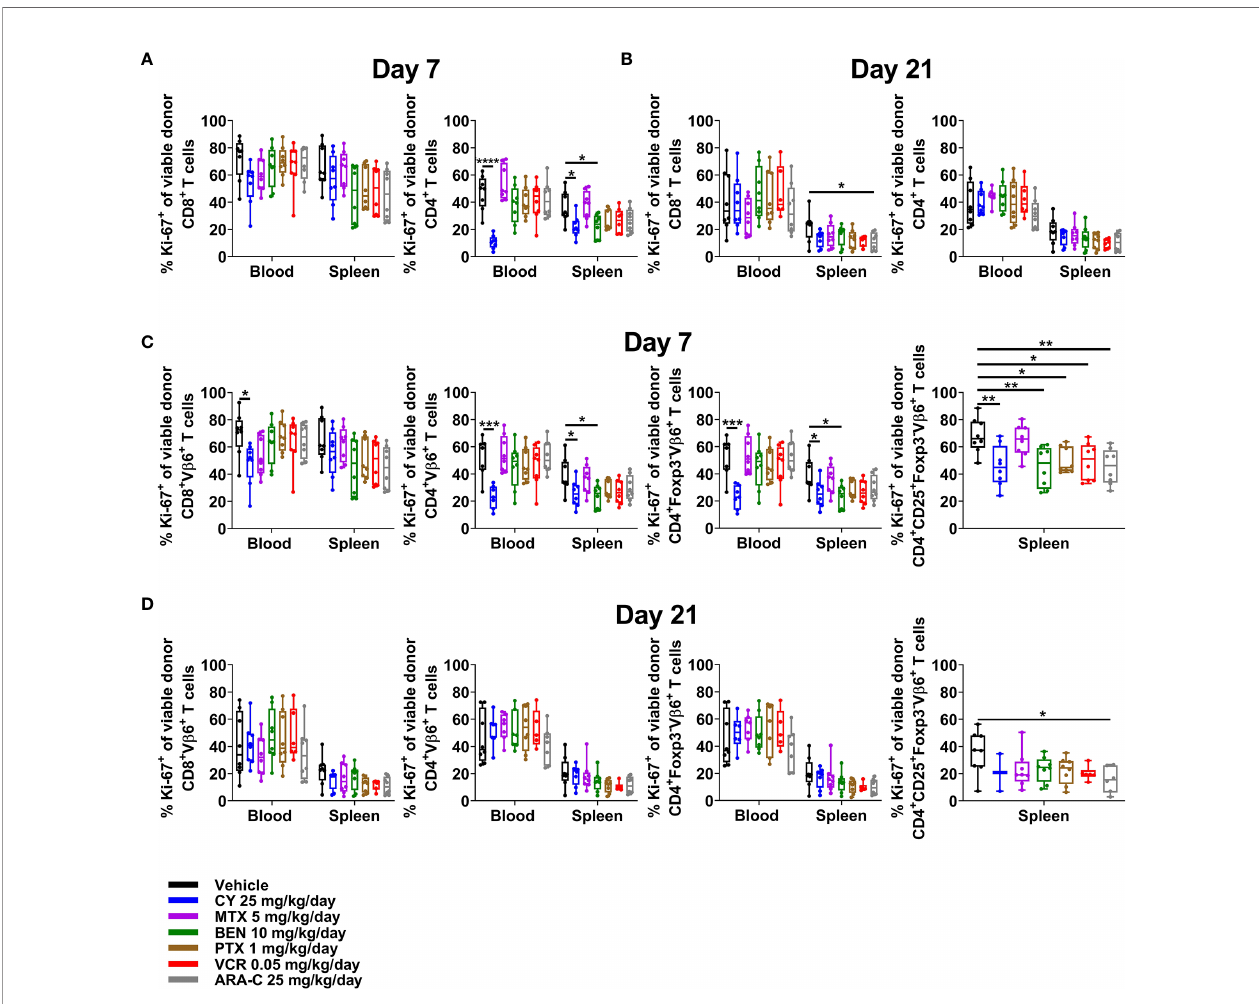
FIGURE 6 | Only CY consistently reduces alloreactive CD4 + T-cell proliferation at day +7. Mice were transplanted, treated with PBS or a chemotherapeutic on days +3 and +4, and euthanized for fl ow cytometric assessment at day +7 or +21 as in Figure 3 . (A) In both the blood and spleens at day +7, CY reduced proliferation (Ki-67 + ) of CD4 + T cells. (B) At day +21, proliferation was generally similar across all groups. (C) CY also reduced proliferation of alloreactive (V b 6 + ) conventional CD4 + T cells at day +7. Interestingly, BEN, PTX, VCR, and ARA-C signi fi cantly reduced percentages of proliferating alloreactive CD4 + CD25 + Foxp3 - T cells at day +7, but did not affect proliferation of other alloreactive CD4 + T cells. (D) At day +21, proliferation of alloreactive subsets again was generally similar across all groups. Percentages of proliferating alloreactive CD4 + CD25 + Foxp3 - T cells in the blood are not shown in (C, D) due to low total numbers of CD4 + CD25 + Foxp3 - V b 6 + cells across treatment groups that did not permit reliable determination of further subsetting. Combined results from two independent experiments are shown with n = 4/ group/experiment for (A – D) except for VCR (n = 6 total) in (B, D) due to excess early deaths. *p < 0.05, **p < 0.01, ***p < 0.001, ****p < 0.0001 on one-way ANOVA followed by the Holm-Sidak post hoc test using the vehicle-treated group as the control. Only signi fi cant results are shown; all other comparisons between treatment groups and the vehicle group are non-signi fi